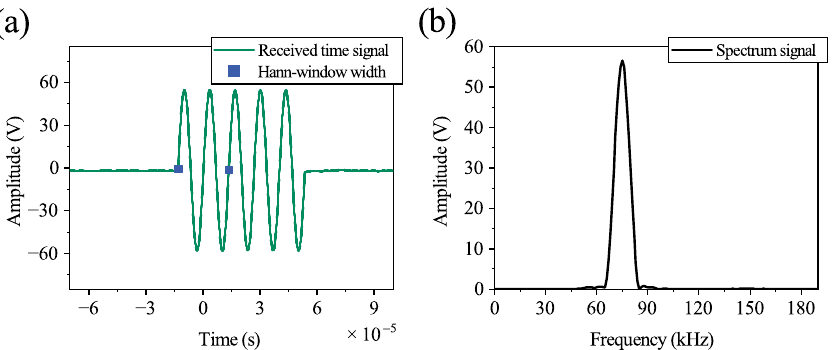
Figure 5. Received signal and spectrum signalfor the amplified signal: ( a ) time-domain signal ( b ) spectrum